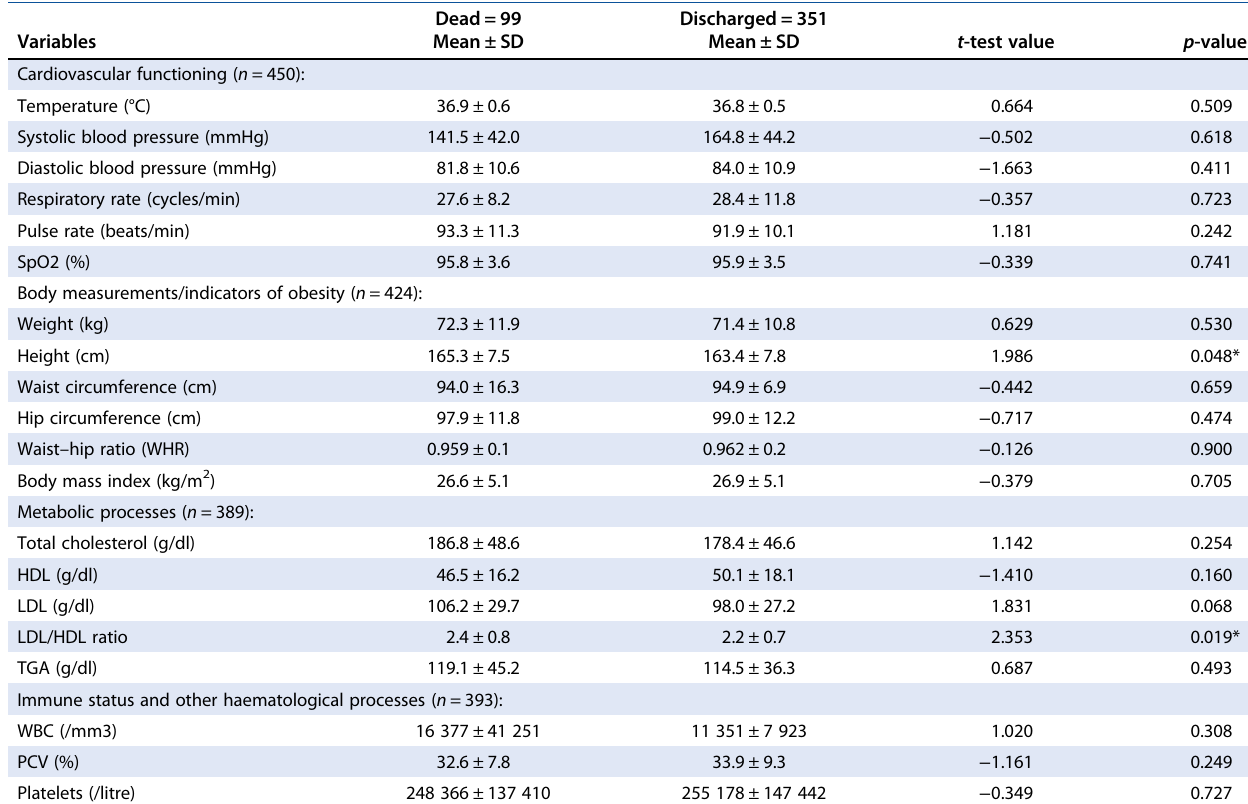
Table 1: Mean values of biomarkers by outcomes of hospitalisation on admission